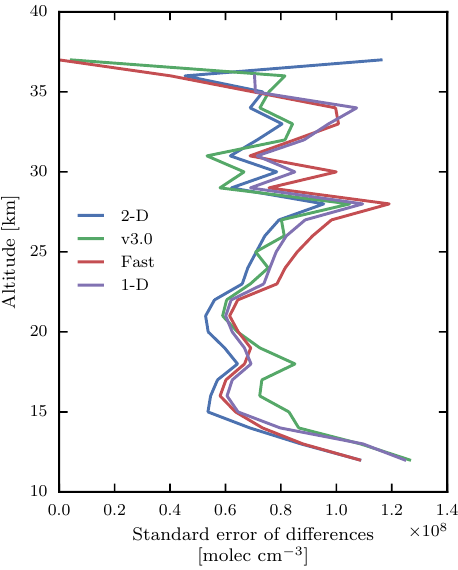
Figure 8. Standard error of the individual biases relative to balloon correlative data for different OSIRIS NO 2 products. The curves here correspond to the half-widths of the error bars in Figs. 6 and 7.